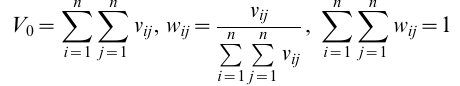
City z Based on inverse power function Based on negative exponential function f f * z * LISA Type